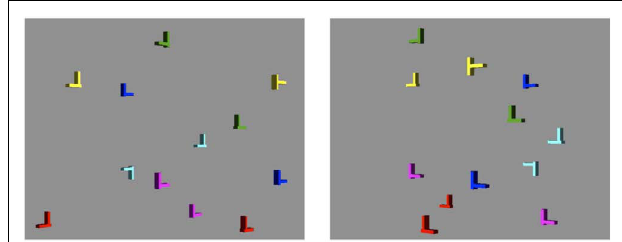
FIGURE 6 | Stimulus example in Experiment 3. The viewpoint changed